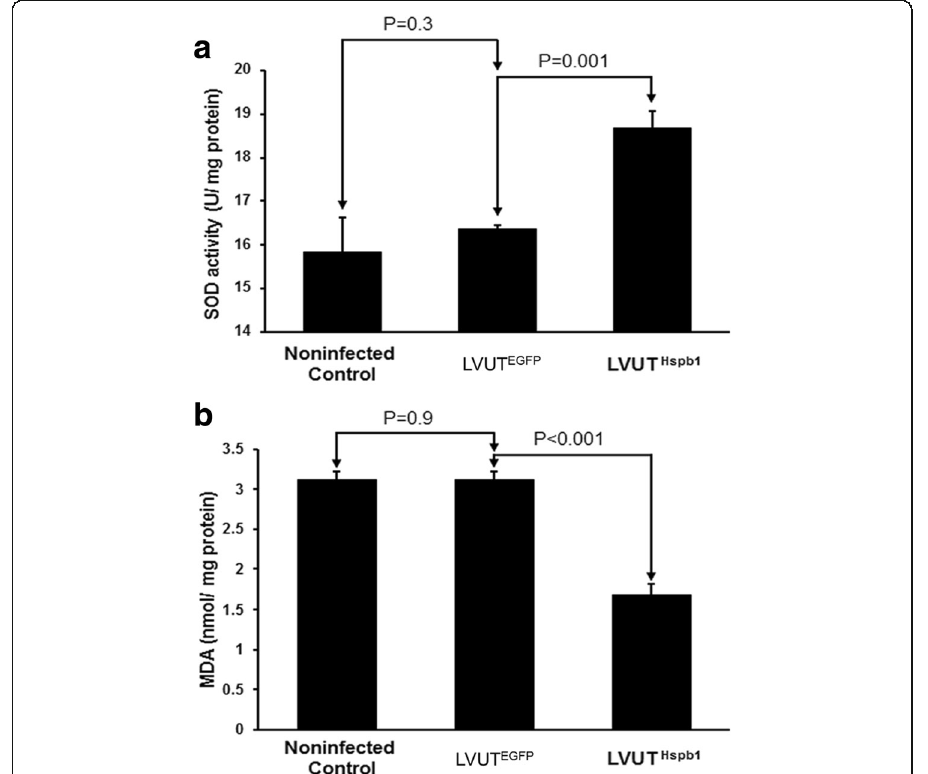
Fig. 7 A10 cells were treated with 2 mmol/l of H 2 O 2 for 2 h. Superoxide dismutase (SOD) activity and lipid peroxidation were tested to reflect the level of oxidative stress. Overexpression of HSP27 significantly increased SOD activity ( a ) and decreased the malondialdehyde level ( b ) in A10 cells infected with LVUT Hspb1 compared with A10 cells infected with LVUT EGFP . These two indexes showed no significant difference between non-infected controls and LVUT EGFP (n =